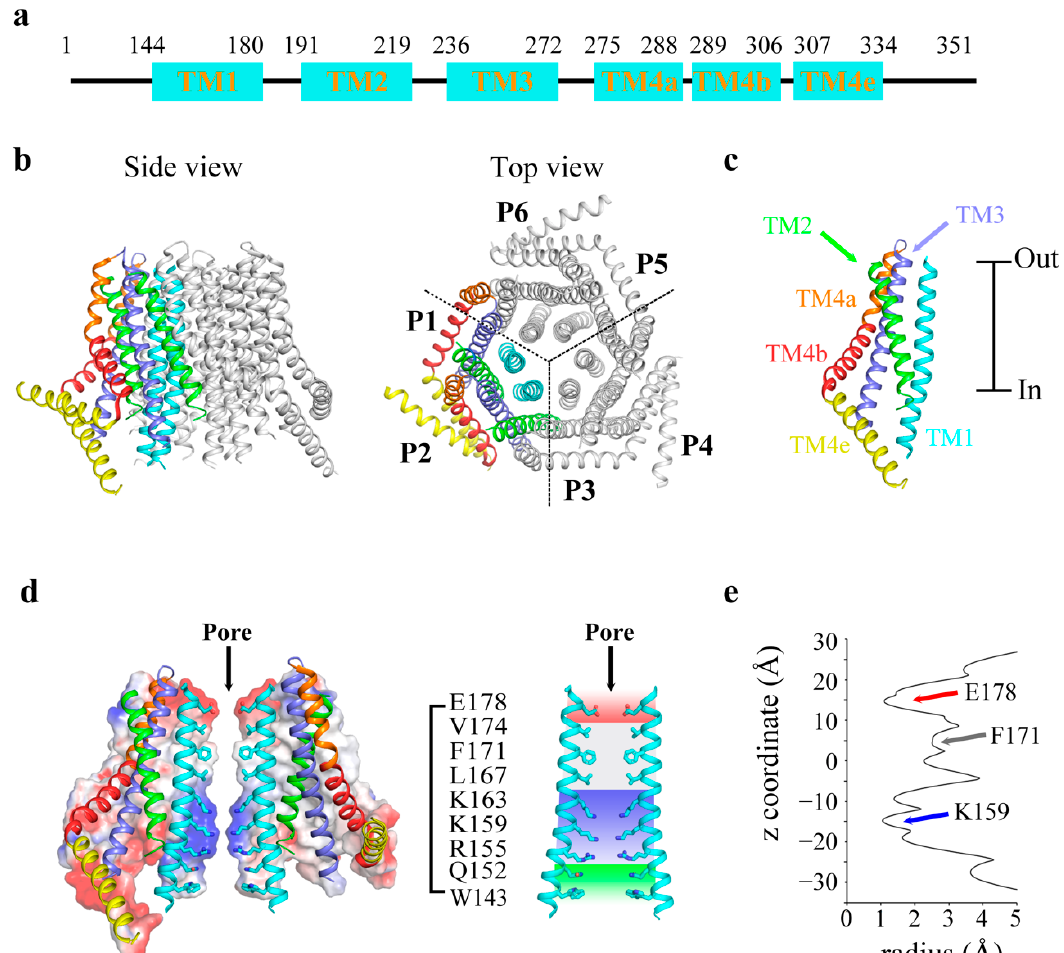
Figure 2. Structure of dOrai channel in a closed state. ( a ) Schematic diagram of the secondary structure labeled with the amino acid number of the dOrai channel. ( b ) Cartoon representation of the overall structure of the dOrai channel from the side and from the top. The dOrai channel shows a hexameric structure with three-fold symmetry. ( c ) Each monomer of the dOrai channel. TM1, TM2, TM3, TM4a, TM4b and TM4e are colored cyan, green, slate, orange, red and yellow, respectively. ( d ) The surface of two opposing subunits around the central pore are colored according to the electrostatic surface potential from − 10 to +10 kT/e (red to blue). The proteins are shown as cartoons, and key residues lining the pore are shown as sticks (carbon, nitrogen and oxygen atoms are colored cyan, blue and red, respectively). Molecular details inside the pores are shown as the glutamate ring (the region colored in red) and hydrophobic (gray), basic (blue) and cytosolic (green) regions. ( e ) Pore radius profile of the dOrai channel along the z coordinate.